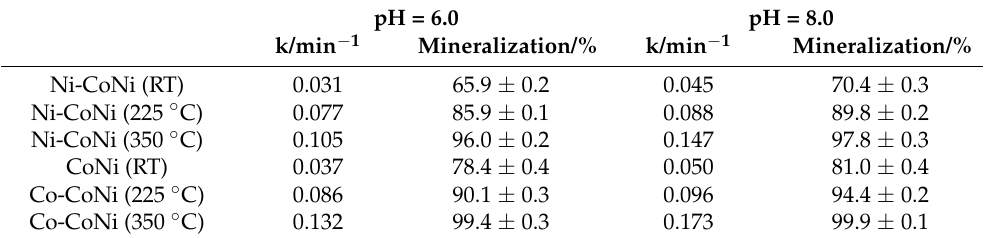
Figure 4. Catalytic degradation of TCs using different Ni–CoNi and Co–CoNi deposits at ( a ) pH 6.0 and ( b ) pH 8.0. Experimental conditions: 20 ppm of TCs [PMS] 0 = 0.3 mM, T = 20 ◦ C, and dark conditions. Table 2. Kinetic constants of the degradation and mineralization of TCs using the Ni–CoNi and Co–CoNi deposits subjected to different thermal treatments. pH =